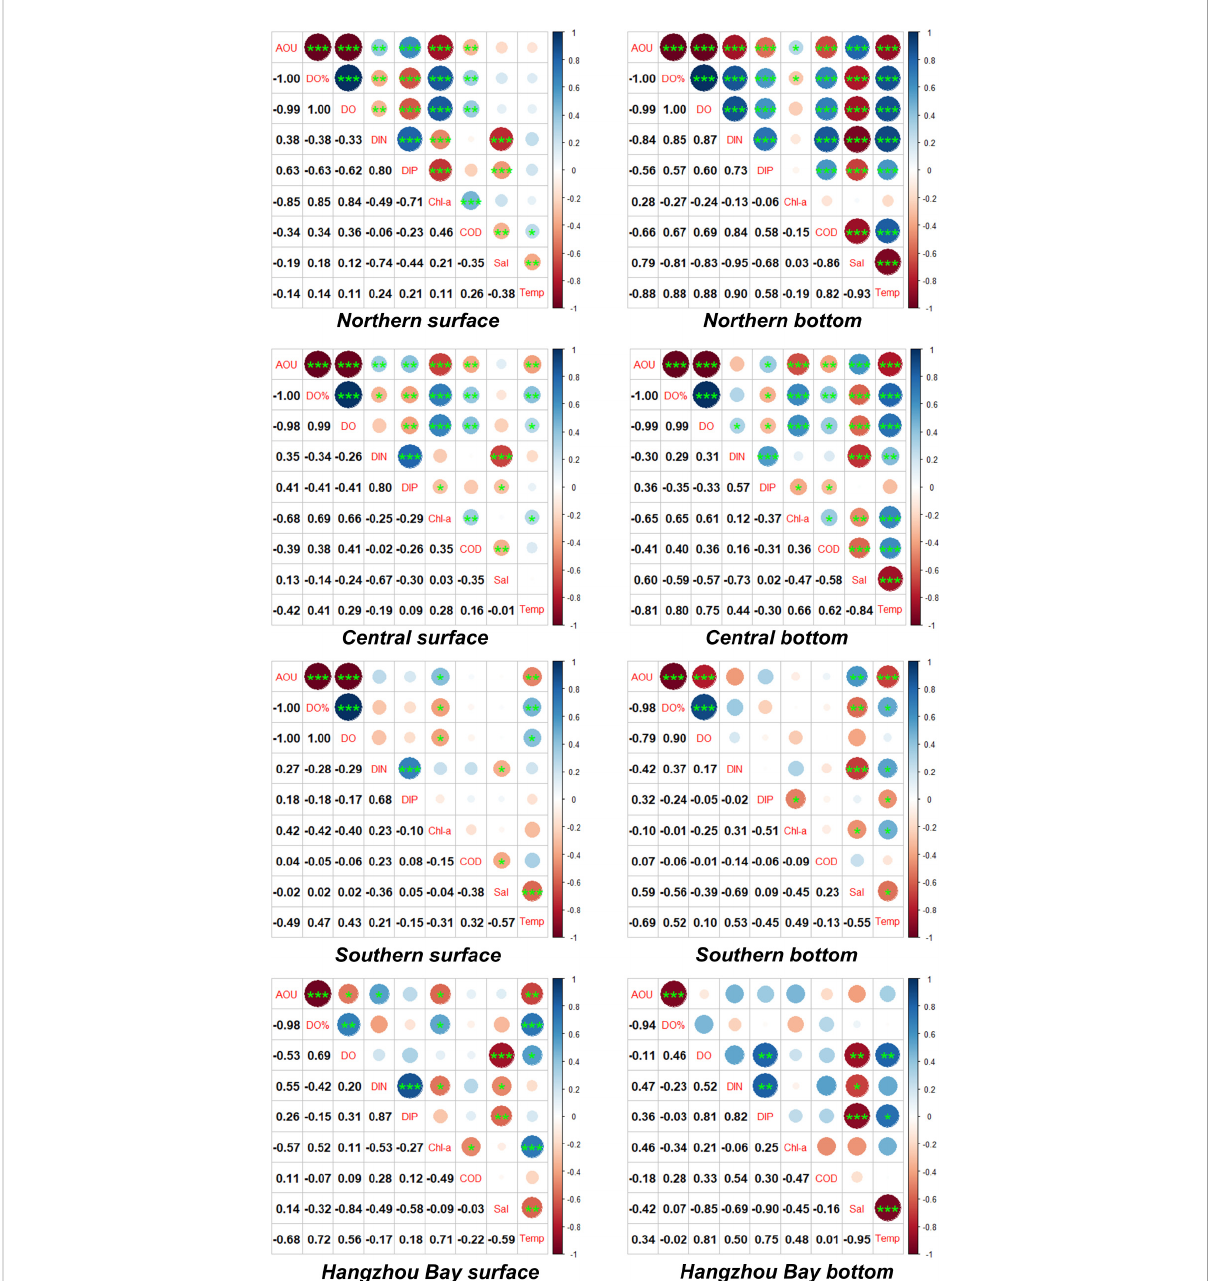
FIGURE 5 Comparative analysis of AOU and biochemical parameters in the Zhejiang Coastal Area. The red circle indicates negative correlation, the blue circle indicates positive correlation, and ***means P<0.001, **means p<0.01, *means